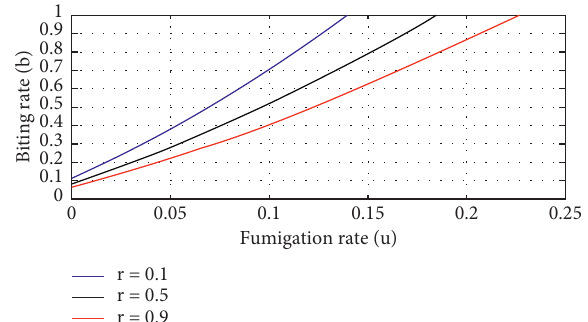
Figure 7: Parameters b and u with the critical line R different values of r